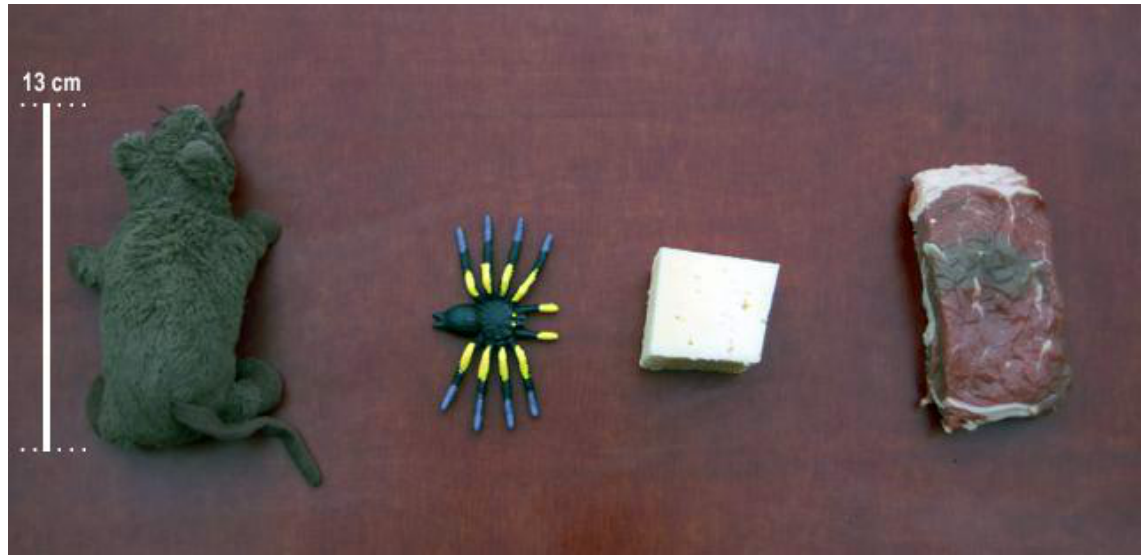
Figure 1. Examples of toys and food items used in the different conditions. From left to right: a stuffed toy rat, a colorful plastic spider, a piece of cheese, and a piece of